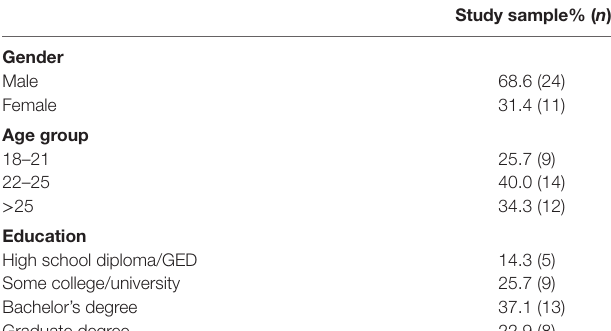
Table 1 | list of sociodemographic factors in the classifier study